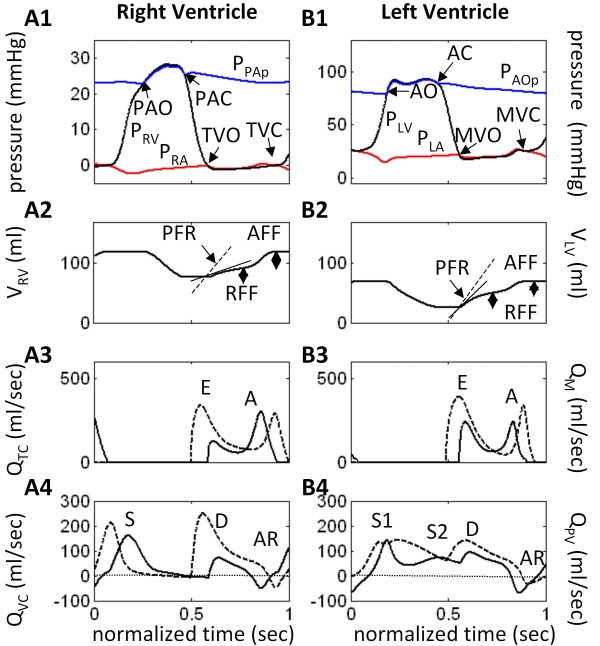
Model Waveforms for Pseudo-Normal Case. Model-generated pressure, volume and flow waveforms under pseudo-normal conditions (PN = combined IR and R conditions). Dashed line plots are the control case for comparison. Abbreviations are as in Figure 2. See text for details.